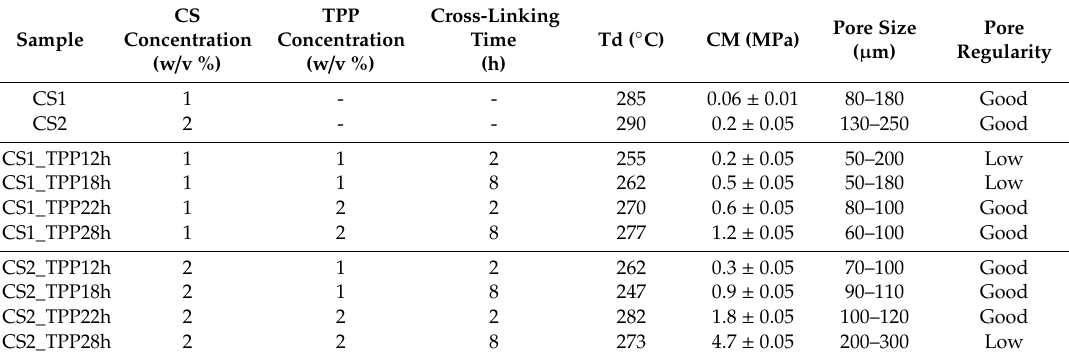
Figure 2. Ionic interactions of CS with tripolyphosphate polyanion (TPP). Table 1. Acronyms and properties of CS_TPP scaffolds. P = porosity; Td= degradation temperature; CM = Compressive modulus.